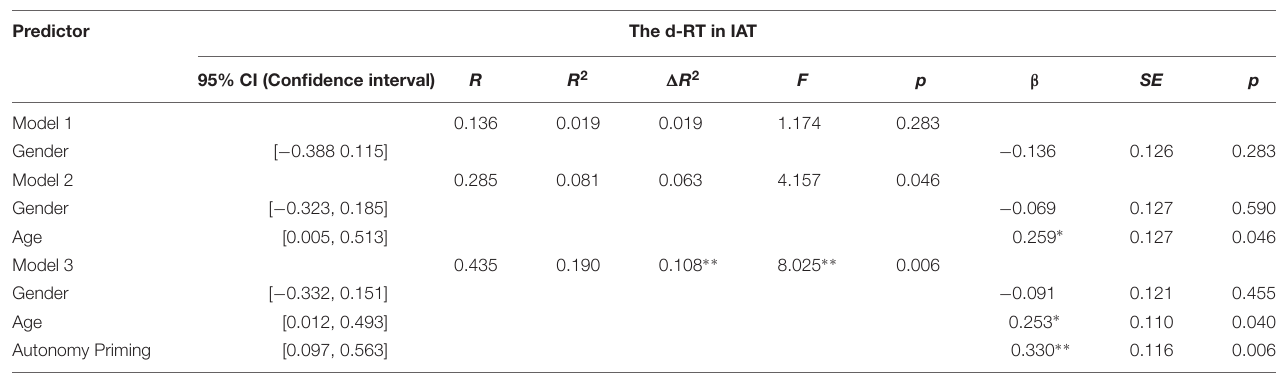
TABLE 5 | The hierarchical regression of predictors on choice effect in Study 2.